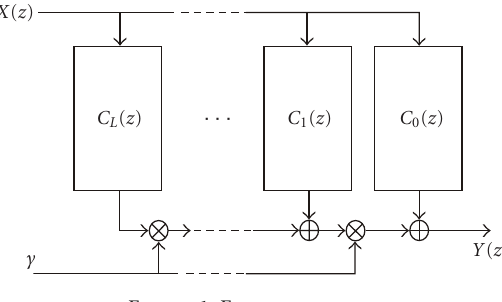
Figure 1: Farrow